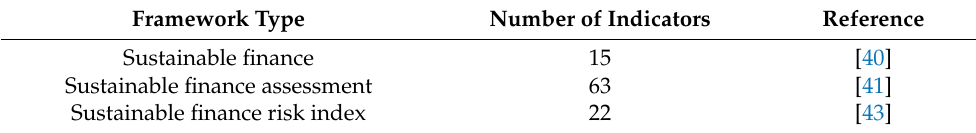
Table 2. Design of sustainable development patterns in previous